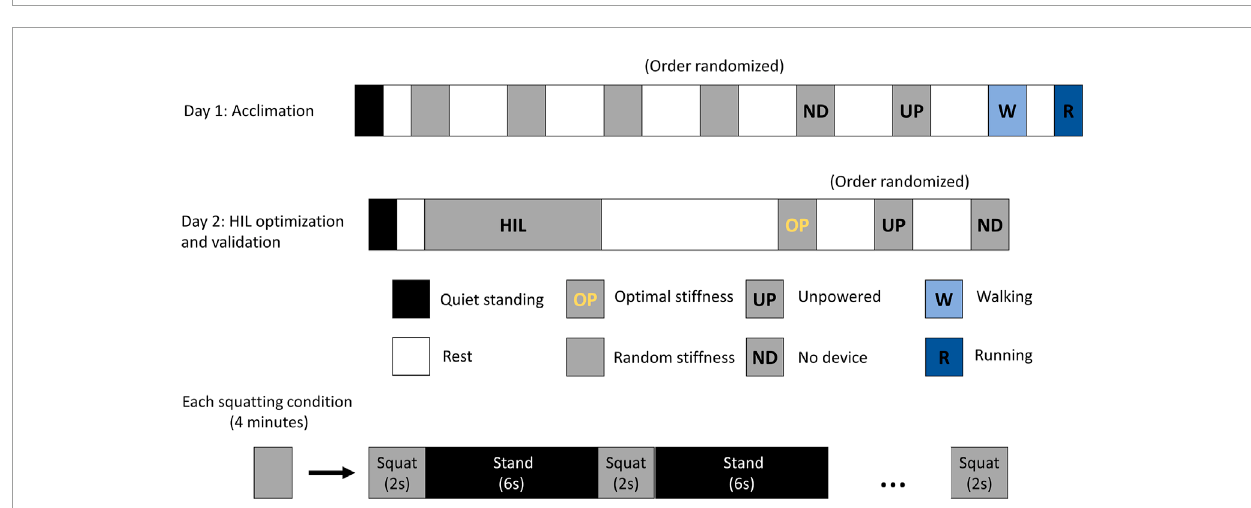
FIGURE 3 Experimental protocol for the exoskeleton personalization study for squatting. On Day 1, the subjects got acclimatized to the exoskeleton. Four different stiffness parameters were used and the corresponding metabolic cost was measured. Day 2 involved HIL optimization and validation of the optimal assistance condition. Each squatting condition lasted for 4 min in total, consisting of alternate squatting (2 s) and standing (6 s).